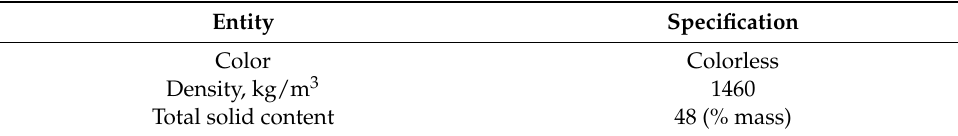
Table 4. The properties of SS solution. Entity Specification Color Colorless Density, kg/m 3